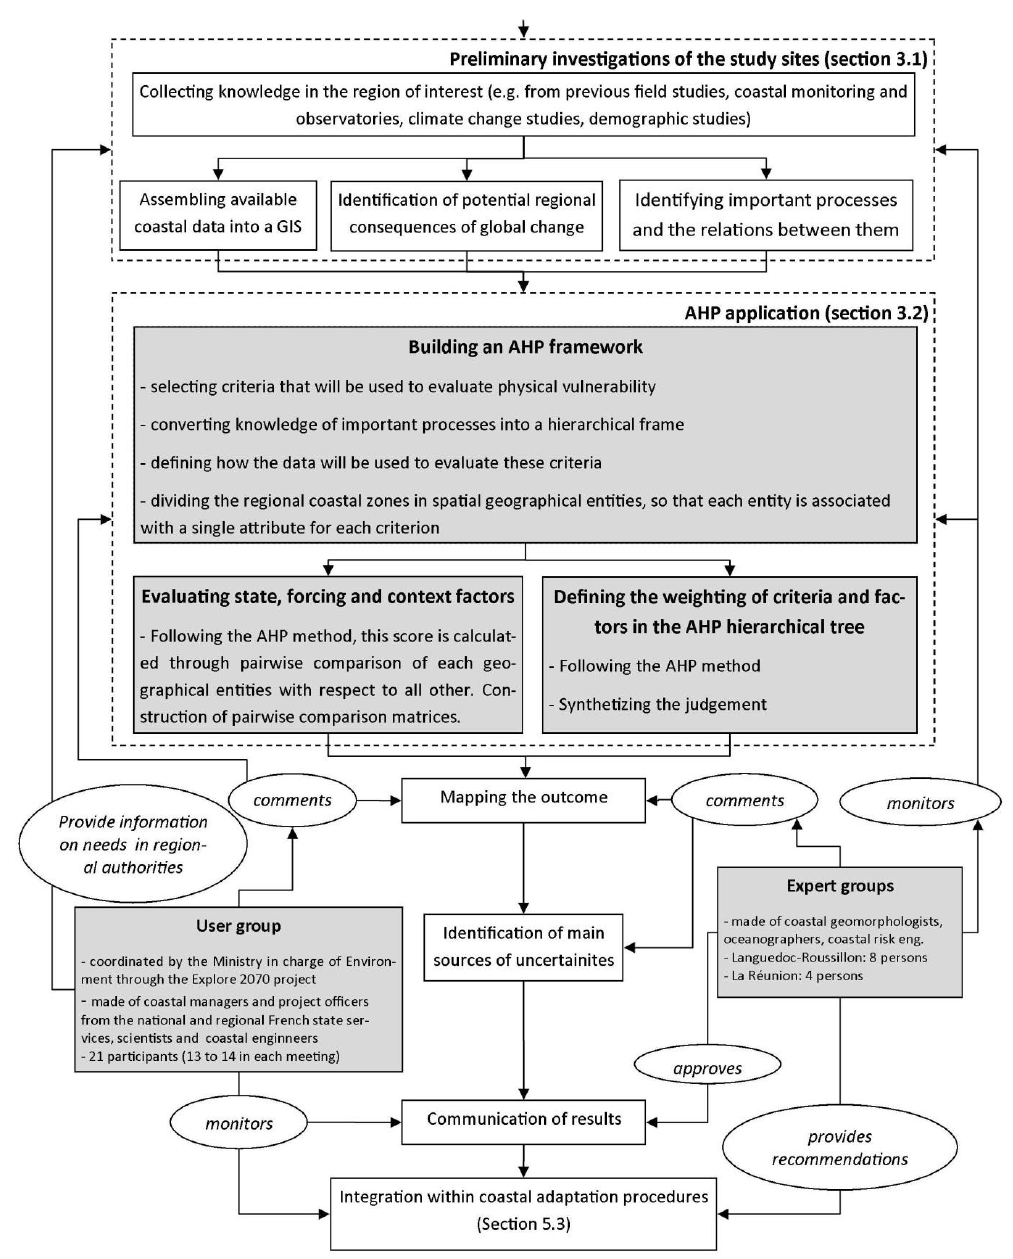
Figure 1: Sequential process used in this study to produce and validate physical vulnerability maps. 823